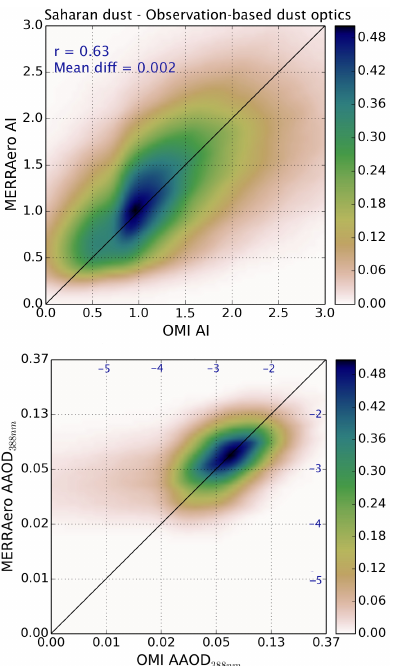
Figure 8. Same as Fig. 7 except that the dust observation-based optics table with the spectral variation of the imaginary part of the refractive index at 354nm relative to the refractive index at 388nm is used in MERRAero